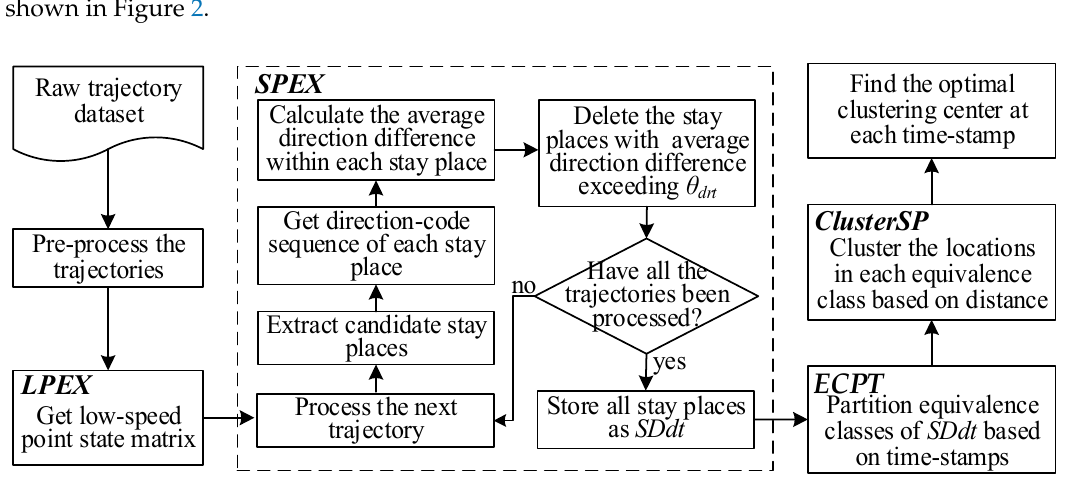
Figure 2. Schematic diagram of the proposed approach.